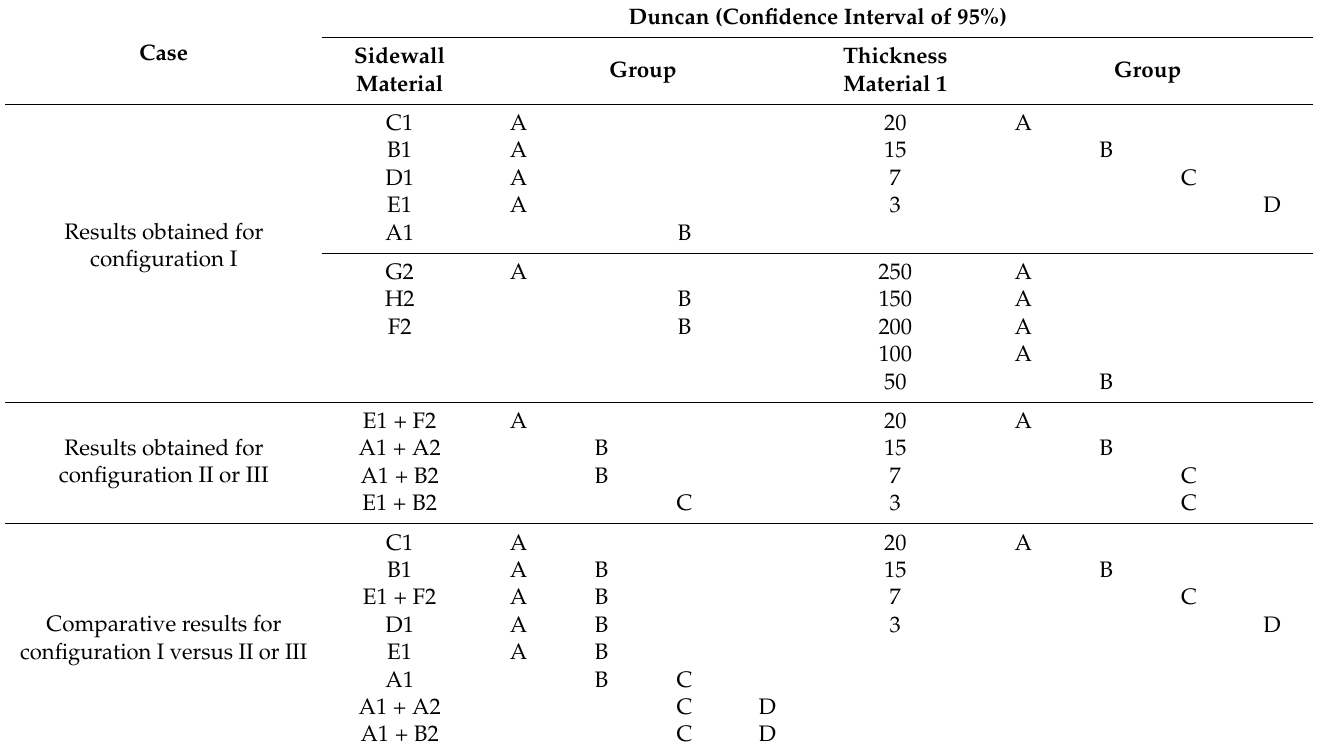
Table 6. Duncan’s test for total heat supplied to the sidewall for different sidewall configurations, materials, and material